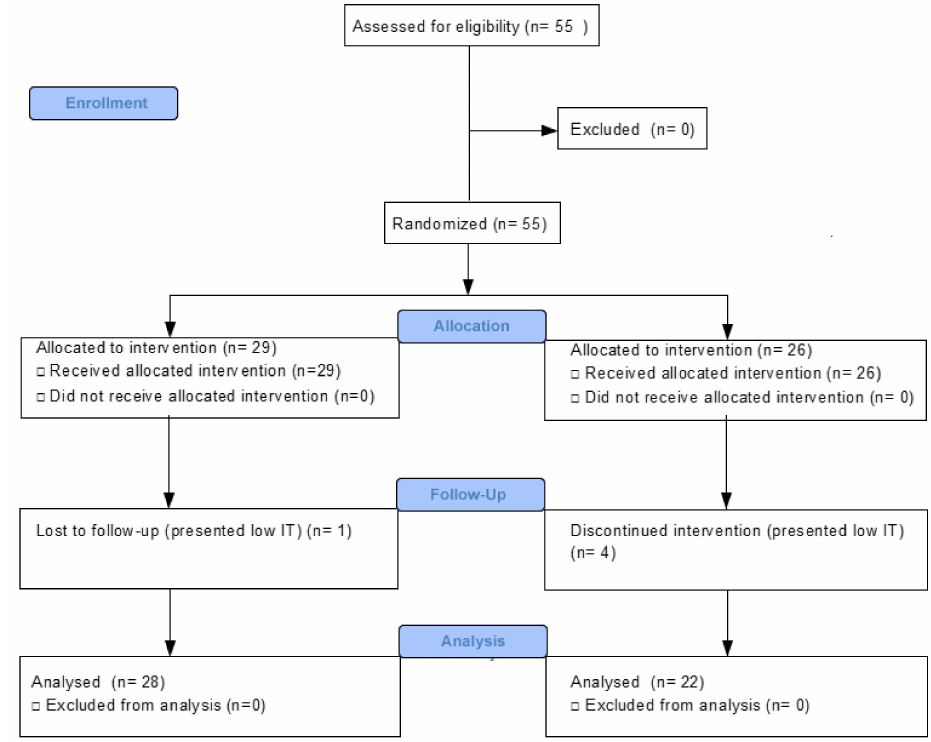
Figure 4. Flowchart (CONSORT) illustrating the implant placements of the clinical trial.